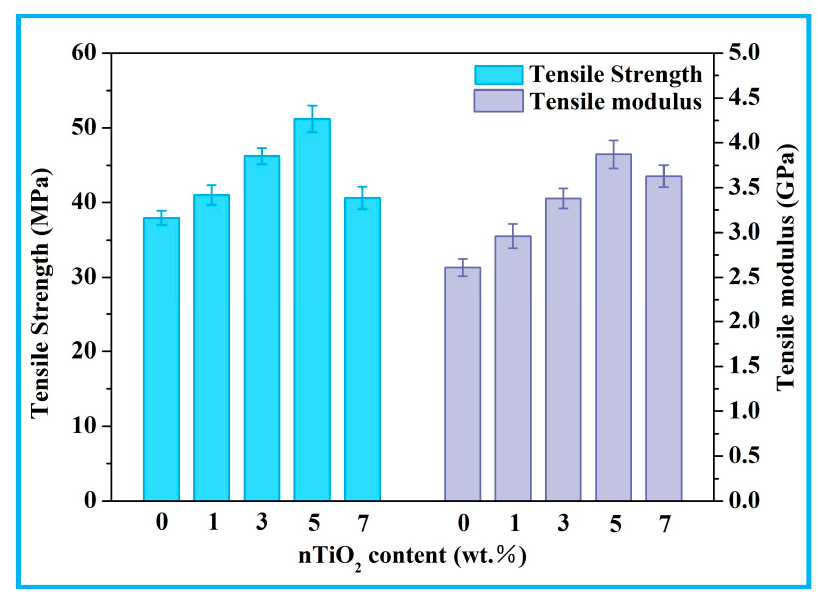
Figure 8. Tensile strength and modulus of the scaffolds with different nTiO 2 contents.